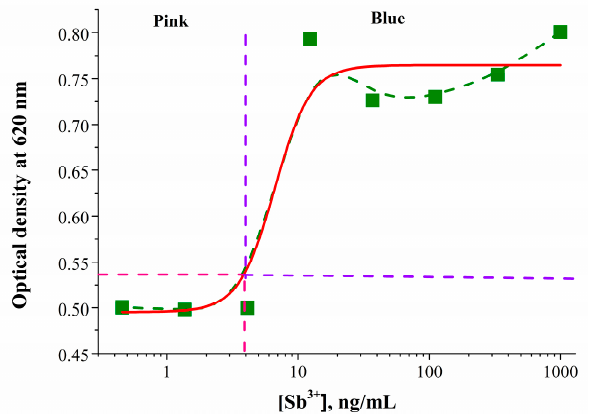
Figure 4. Calibration curve for Sb 3 + detection (with the use of GNP–PAO conjugate). The value of 0.55 indicates the absorbance of gold conjugate at 620 nm in the absence of antimony. The points above and to the right of optical density 0.5 correspond to the blue color of the final reaction mixture, and the points below and left of this level correspond to pink (y = 0.76 + (0.50 − 0.76)/(1 + (x/6.6)^3.19), (R 2 = 0.95)). All experiments were undertaken in three replicates. Standard deviations from the mean were in the range 2.1–5.8%.